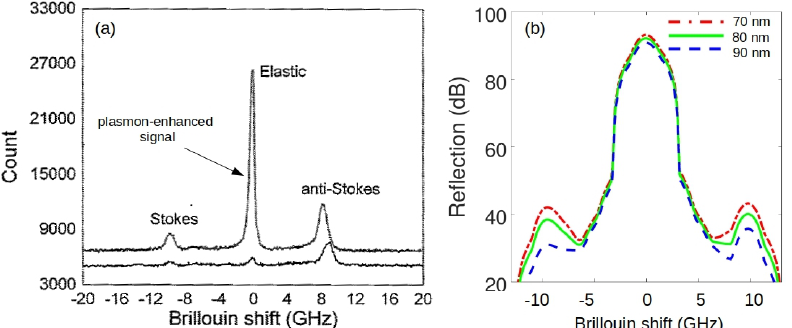
Figure 9. ( a ) Typical experimental BLS spectra with and without a gold disc nanostructure obtained after 5s integration time using the excitation laser power of 40mW. Note a significant signal enhance- ment due to the plasmon modes supported by the disc nanostructure. Reproduced from [16] with permission of SPIE and the corresponding author of this publication. ( b ) BLS spectra calculated using a 3D finite-difference time-domain model of the plasmon BLS effect for different disc diameters. Due to high computational demands, the integration time in the model was limited to 0.5ms and window filtering was used, which increased the linewidth of the peaks. Note that the model reproduces the fact that in the experiment the amplitude of the anti-Stokes peak is higher than that of the Stokes peak. The BLS signal without the nanodiscs was not